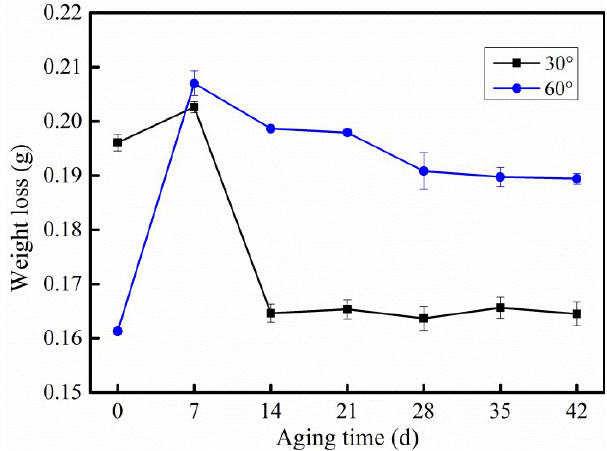
Figure 8. Sand erosion test of CF / PC composites, 1 min, 50 psi.